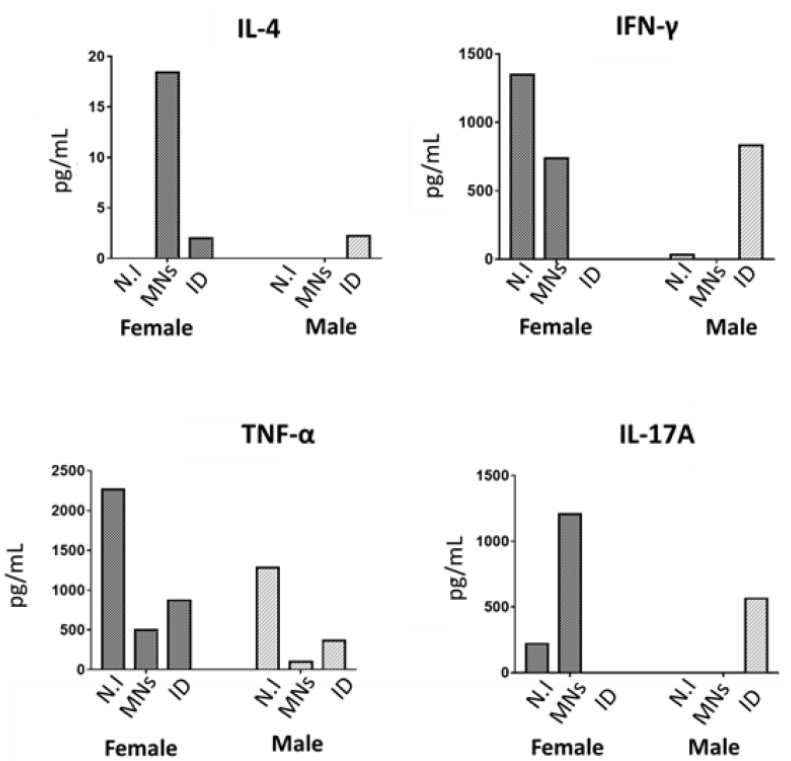
Figure 6. Splenic cytokine profile in immunized BALB/c female and male mice with rLTB-loaded microneedle patches (MNs) or with rLTB through intradermal route (ID). Non-immunized (N.I) mice were used as a negative control. Cytokine levels were determined by ELISA and expressed in